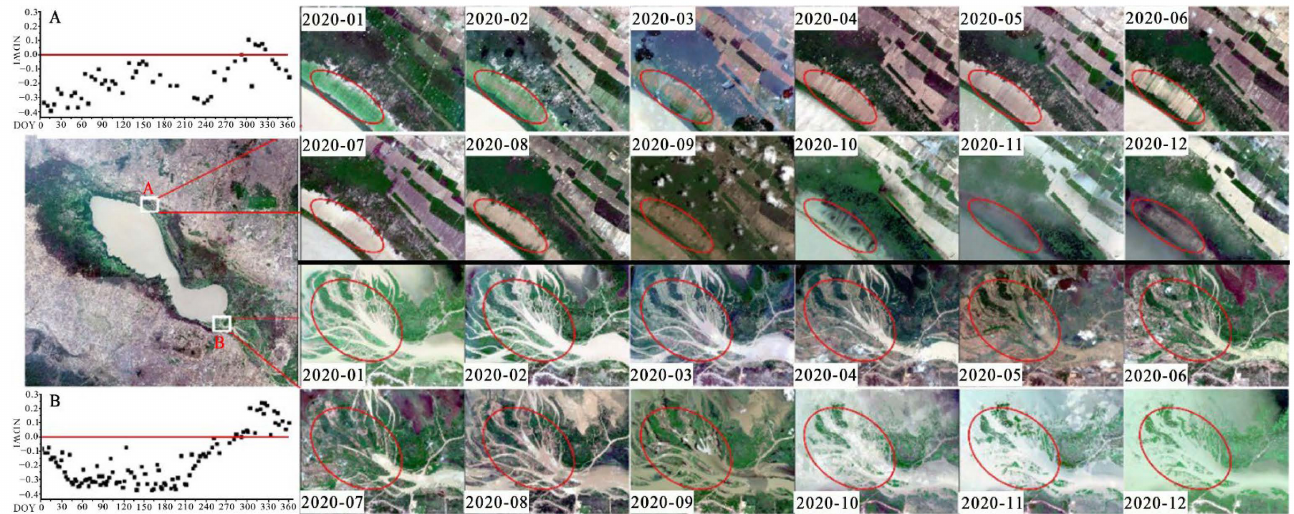
Figure 4. The inundation dynamic of the Tonle Sap lake: ( A , B ) are the NDWI values and Sentinel-2 images of two sites of the Tonle Sap